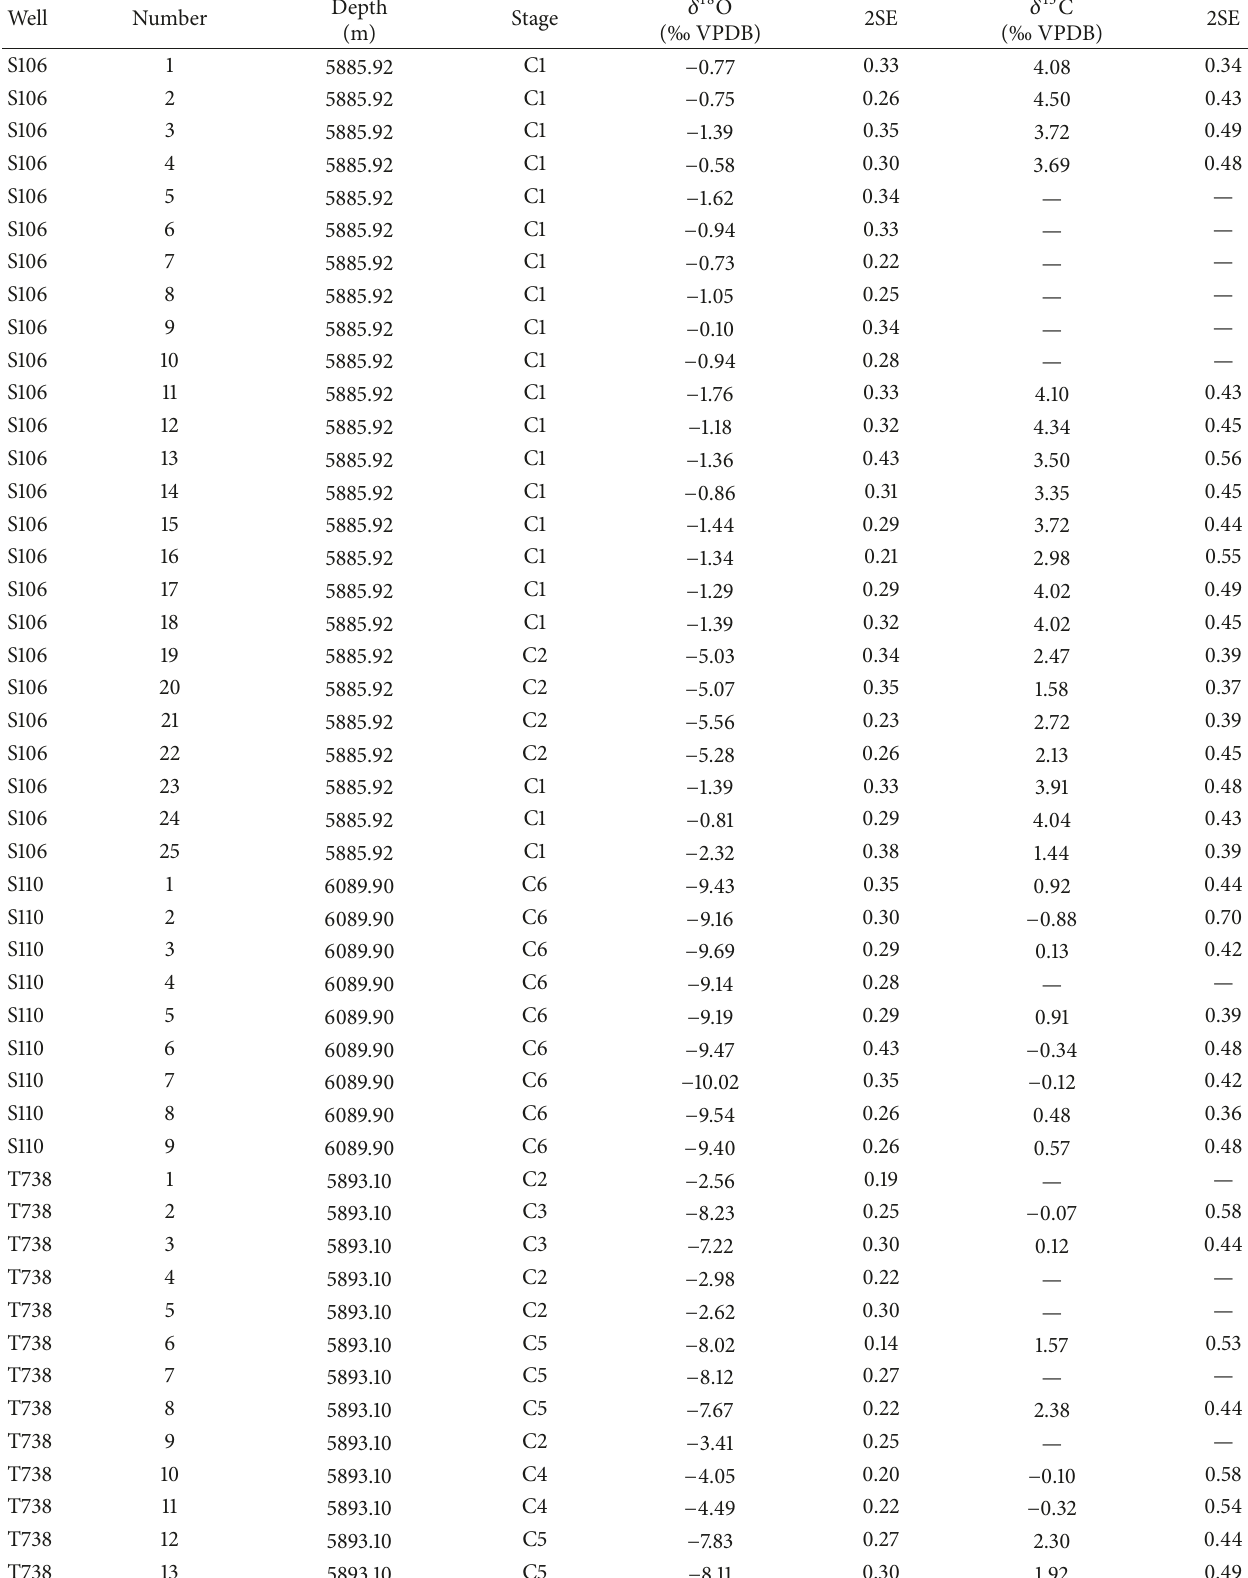
Table 1: Carbon and oxygen isotopic data of different stages of pore-filling calcite cement by in situ SIMS of Lianglitag Formation carbonates in the Tahe